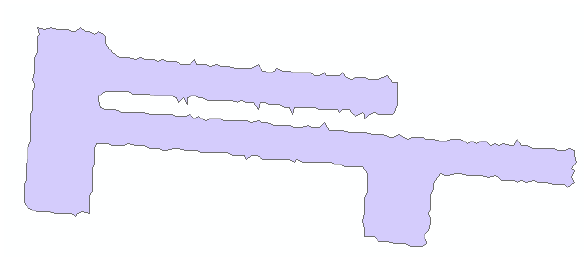
Figure 6. Flow chart